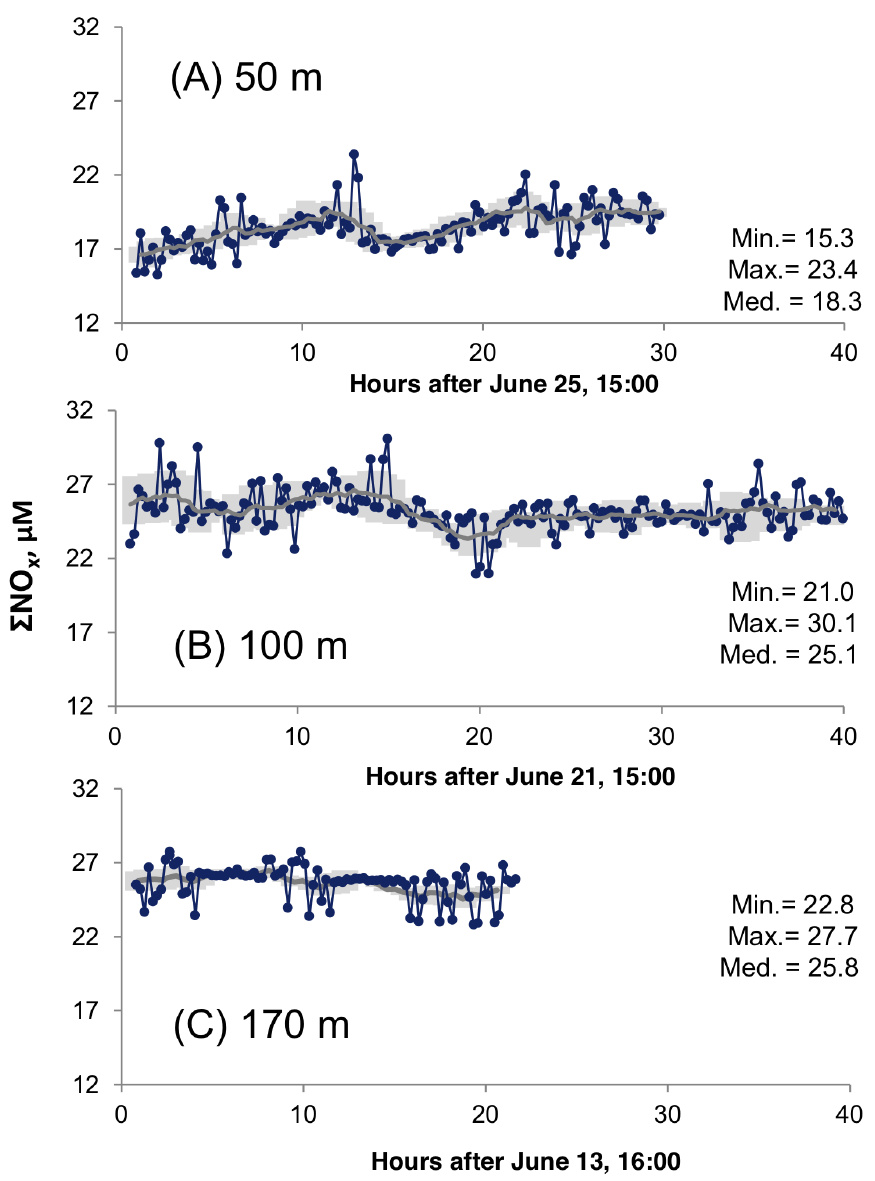
Fig 4. Time series measurements of NO3-+ NO2- ( Σ NO x ) in bottom waters. The time axis indicates time starting from the first sensor measurement in each respective deployment (see Table 1 for dates). The gray line in each series denotes a 12-point moving average. Also plotted as gray shading is ‘ moving uncertainity ’ corresponding to concentrations calculated from two times the moving (n = 5) standard deviations of the successive in situ measurements of a standard solution (Table 2). Any point outside the gray area very likely reflects natural